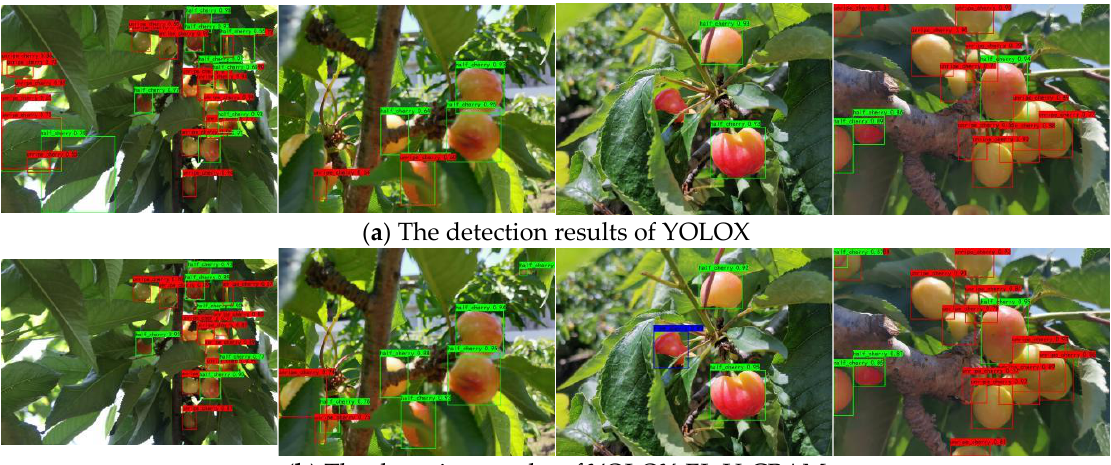
Figure 8. Comparison of the detection results of YOLOX and YOLOX-EIoU-CBAM. ( a ) The detection results of YOLOX. ( b ) The detection results of YOLOX-EIoU-CBAM.